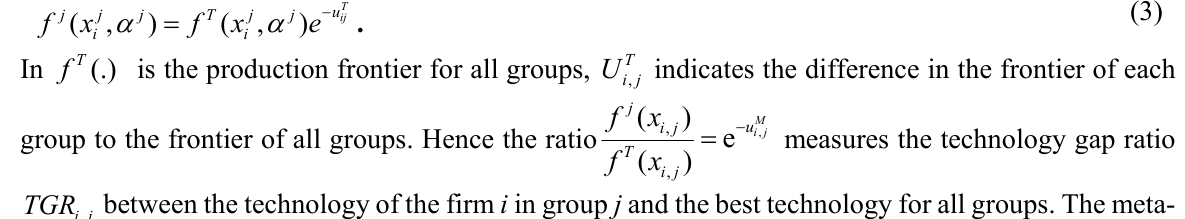
indicates the difference in the frontier of